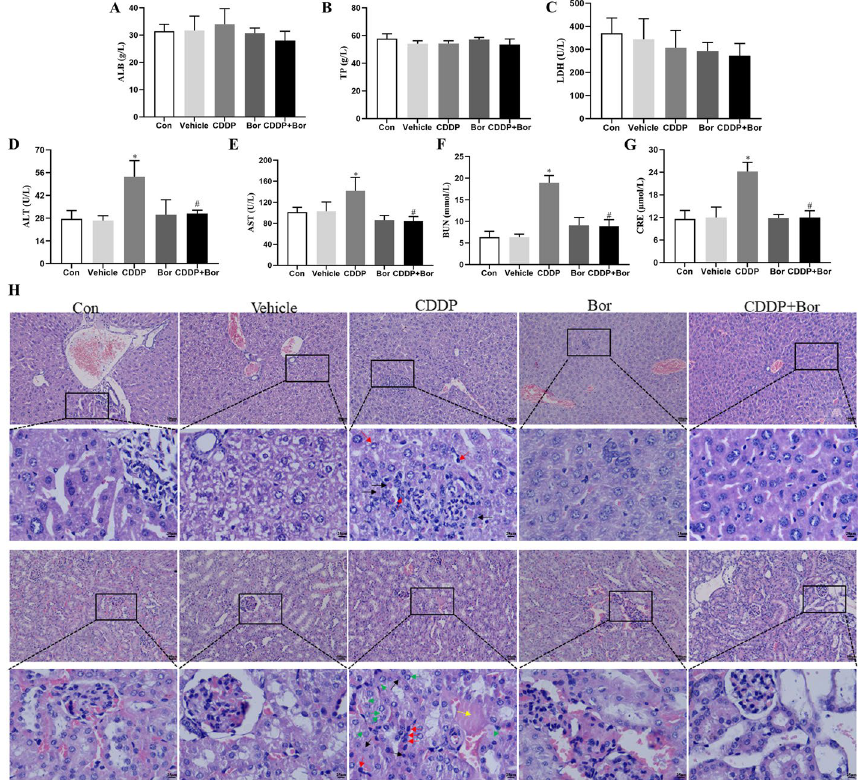
Fig. 7 In vivo biotoxicity assessment. A – G Blood biochemistry data, including ALB ( A ), TP ( B ), LDH ( C) , ALT ( D ), AST ( E ), BUN ( F ), and CRE ( G ). H H&E-stained results of liver and kidney. The pathological changes were observed under light microscope with 100 and 400 magnification. Red arrow represents inflammatory × × cells, black arrow represents necrosis, green arrow represents renal tubular epithelial edema cells, yellow arrow represents damaged casts. Each value represents means SD ( n 6, * P < 0.05, compared with Con, ± = Vehicle, Bor group; # P < 0.05, compared with CDDP